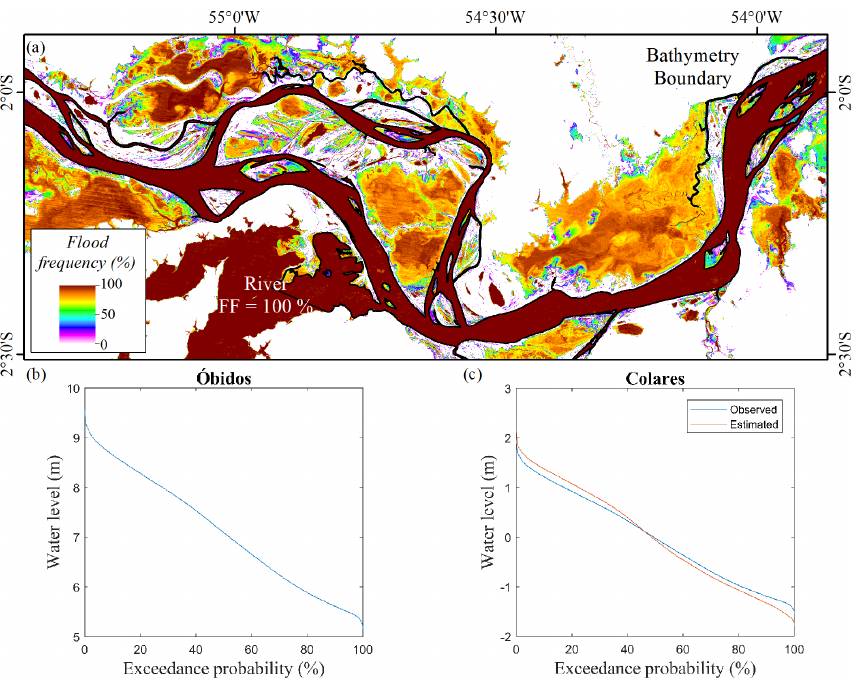
Figure 4. (a) Close-up view of the flood frequency map over the Amazon estuary’s upstream area. (b) The water level duration function at Óbidos station. (c) The observed and estimated water level duration function at Colares station. (See Fig. 1 for the location of these two